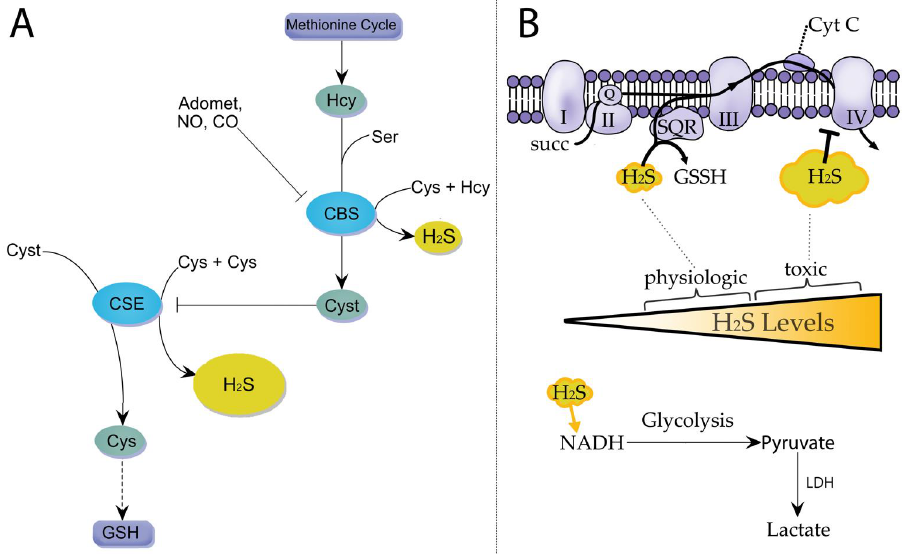
Figure 1. Proposed role of the transsulfuration pathway in producing H 2 S ( A , B ). Homocysteine (Hcy) is utilized with serine (Ser) by CBS to produce cystathionine (Cyst). The heme domain within CBS is sensitive to allosteric regulation by ligands (NO, CO, and Adomet), whose concentrations change transiently in response to stimuli. CBS may catalyze H 2 S elimination following condensation of cysteine (Cys) with Hcy. Under basal conditions, Cyst outcompetes Cys utilization by CSE to generate Cys, which contributes to glutathione (GSH) synthesis. Heme-regulated switching of CBS activity or changes in CBS protein levels regulate CSE-derived H 2 S versus cysteine synthesis (Panel A ). H 2 S exerts a biphasic role upon mitochondrial bioenergetics, and H 2 S concentrations influence